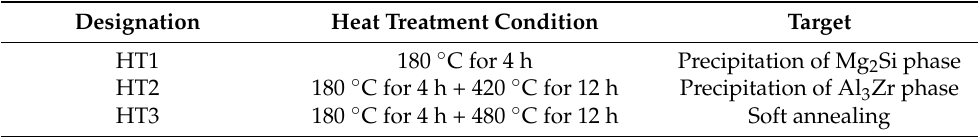
Table 1. Summary of post-heat treatment conditions.